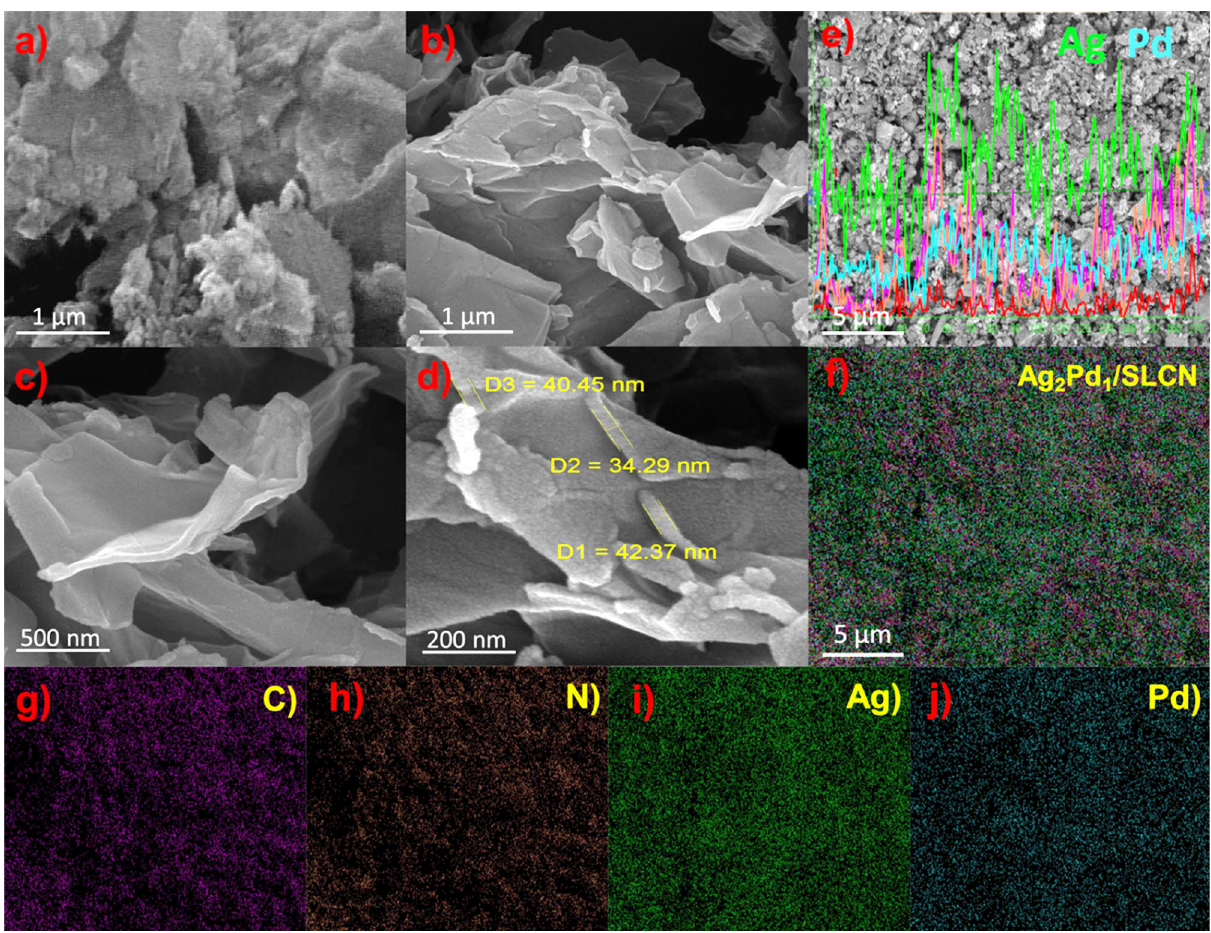
Figure 4. ( a ) SEM images of bulk g-C 3 N 4 , ( b , c and d ) SEM images of SLCN, ( e ) EDS-SEM line scan profiles of